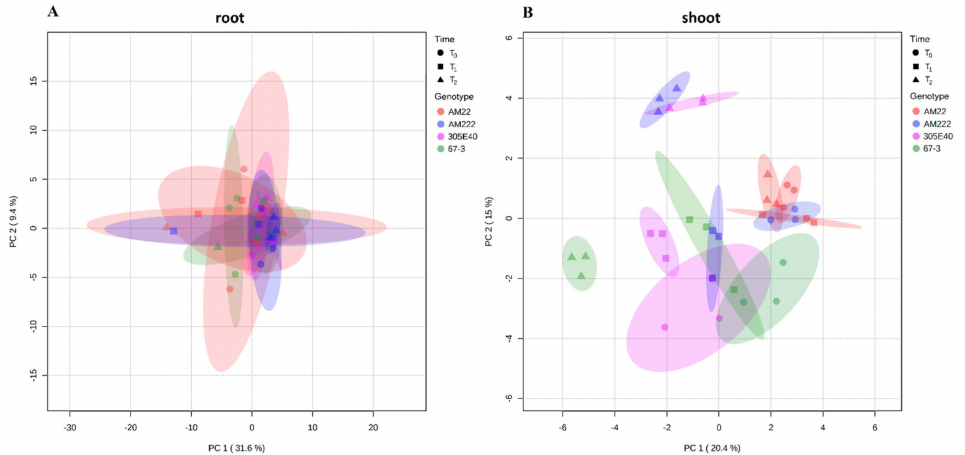
Figure 1. Two-dimensional plot of principal component analysis (PCA) of eggplant metabolites for root ( A ) and shoot ( B ). The dots represent accessions with 95% confidence regions as ellipses. ( A ) In root, PC1 and PC2 explained 41% of total variation; time sampling and accessions are not clearly distinguished. ( B ) In shoot, PC1 and PC2 explained 35.4% of total variations; AM22 do not respond to N limitation, while the other genotypes are clearly distinguished by treatments